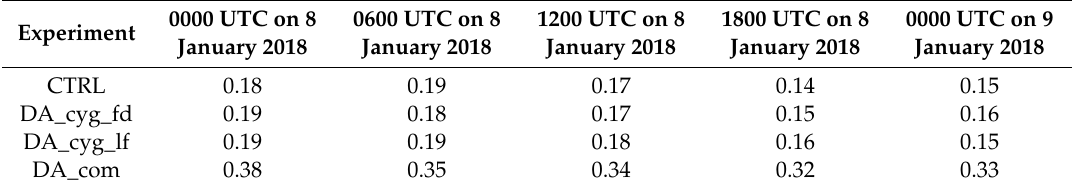
Table 3. Threat Score of precipitation forecast with threshold value of 2 mm h − 1 0000 UTC on 8–9 January 2018 for di ff erent experiments with IMERG rainfall as the reference